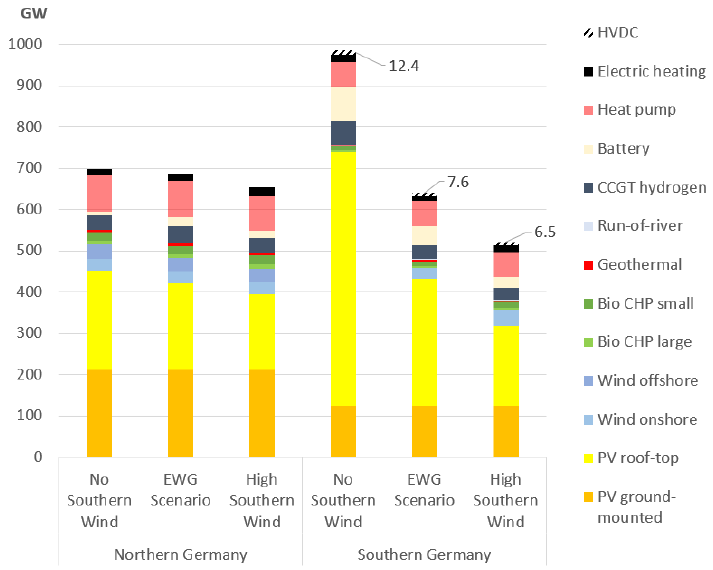
Figure A1. The necessary energy conversion capacity in northern and southern Germany roughly reflects the ratio of consumption of 3:2 between the north and south in the EWG Scenario and under the High Southern Wind assumption. If wind power is not expanded in southern Germany, substantially higher PV capacities are needed, reflecting an increase in storage losses and curtailment. Moreover, the demand for new HVDC lines—assigned to the southern bars here—increases by more than 60 percent.